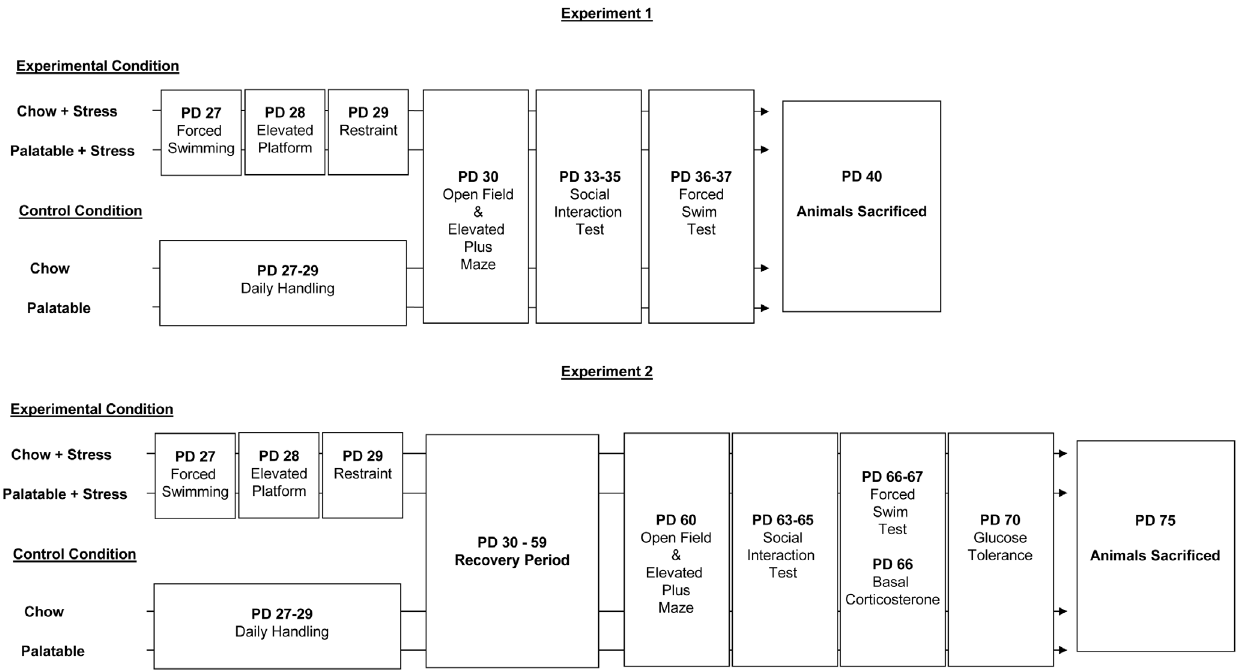
Figure 1. Summary of study design. Animals assigned to stress condition were exposed to a different stressor per day from PD 27–29 while control animals received daily handling. All animals were tested in the indicated behavioral paradigms as described in each experiment.